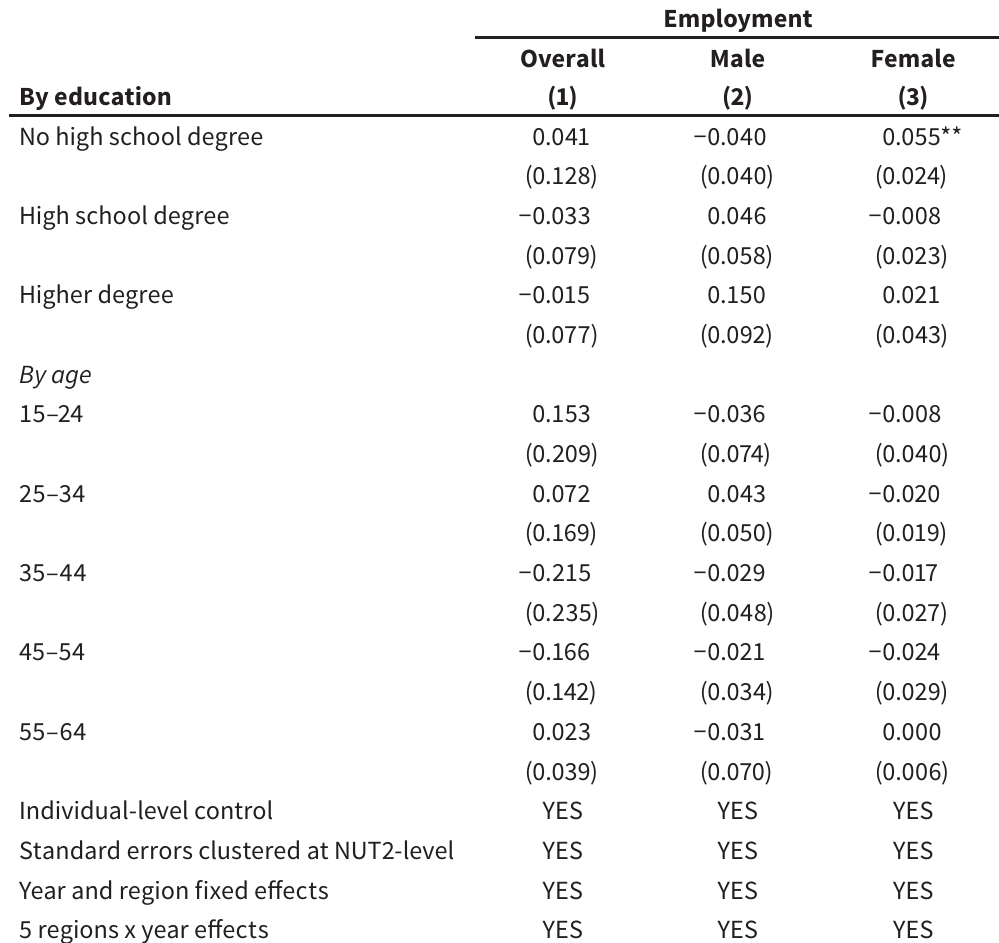
Employment effects, baseline estimation using the baseline fraction affected exposure